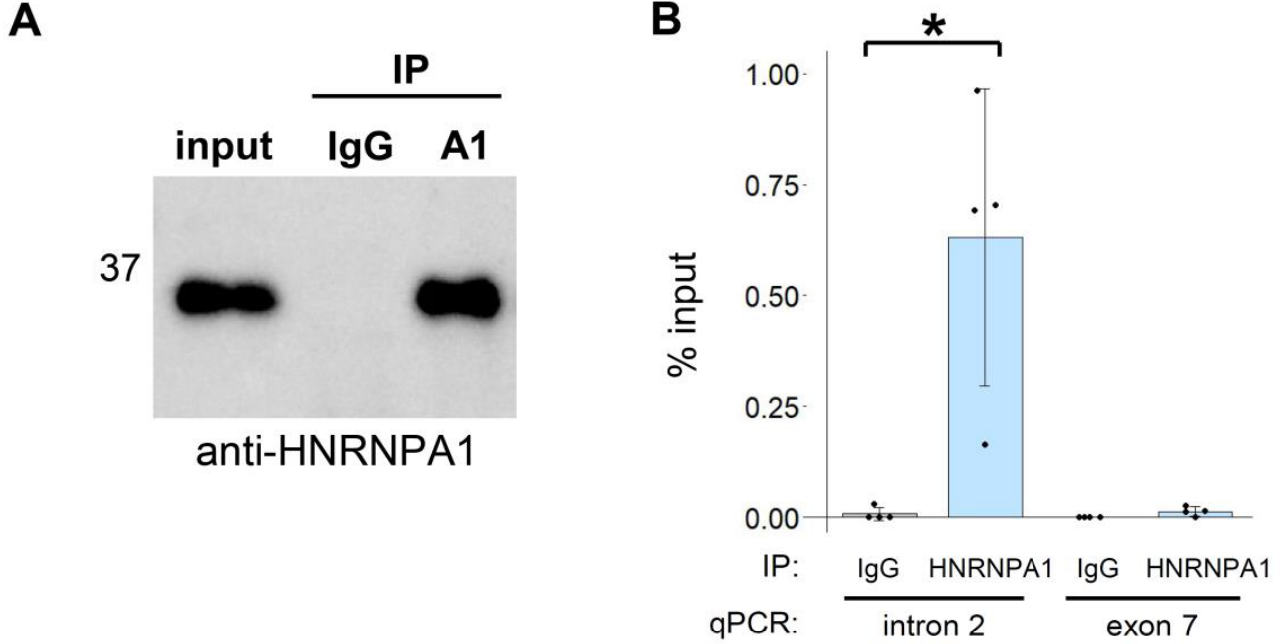
Figure 4. Ribonucleoprotein immunoprecipitation (RIP) of HNRNPA1 and CD33 . ( A ) Immunopre- cipitation of HNRNPA1 in THP-1 cells using an anti-HNRNPA1 antibody. ( B ) Two regions (intron 2 and exon 7) of CD33 were amplified by RT-PCR using RNA in anti-HNRNPA1 antibody or IgG immunoprecipitates. The bar chart shows the results of the quantitative PCR analysis of CD33 ( n = 4). Error bars represent SD. * p = 0.034 (Welch’s t -test).